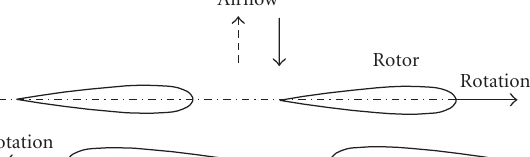
Figure 5: Turbine using self-pitch-controlled blades (TSCB).